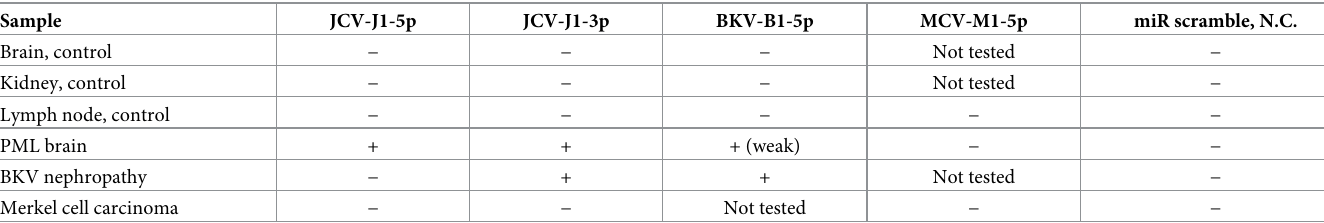
Table 1. In situ hybridization for polyomavirus miRNA in pathological